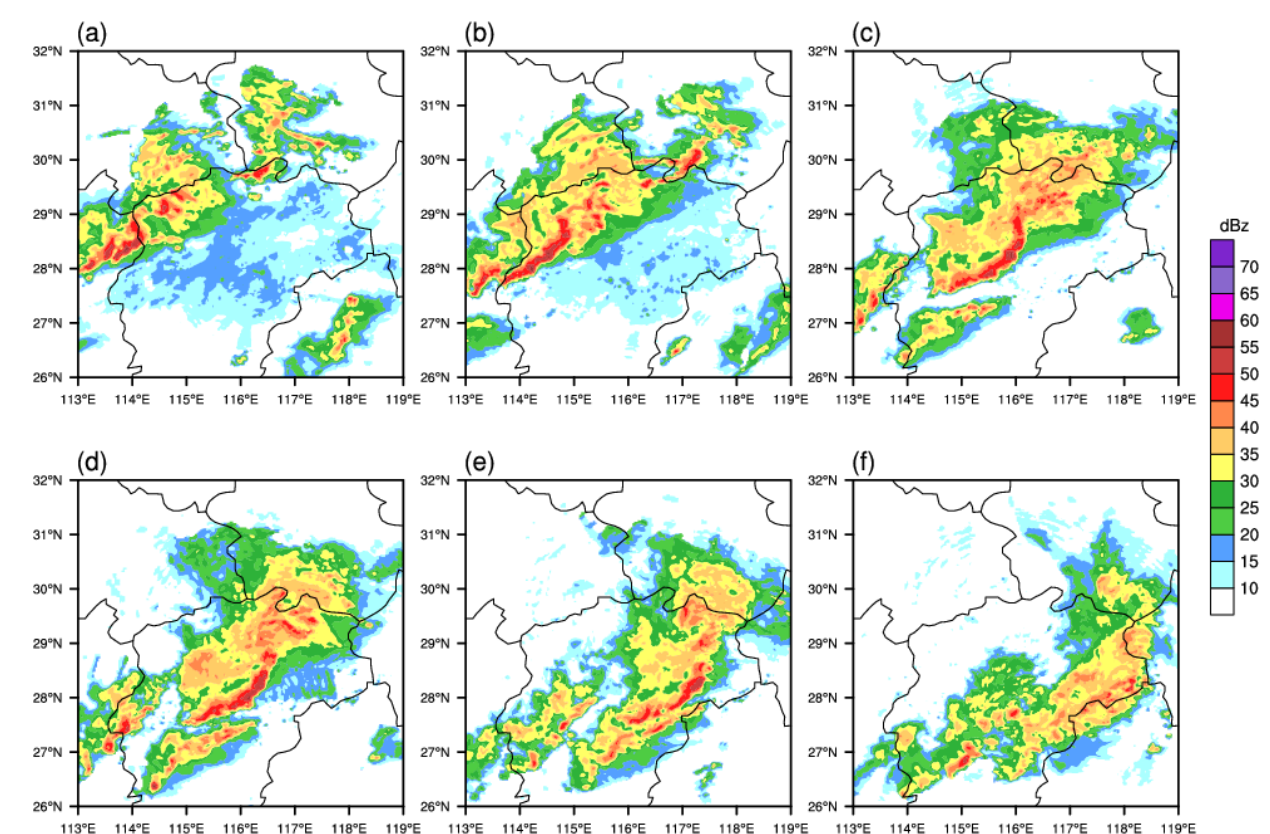
Figure 4. Evolution of radar composite reflectivity (shaded, units: dBz) at 2000 UTC, ( a ) 100 UTC, ( b ) 2230 UTC, ( c ) 2300 UTC, ( d ) 15 April 2016 and 0000 UTC, ( e ) 0100 UTC, ( f ) 16 April 2016.